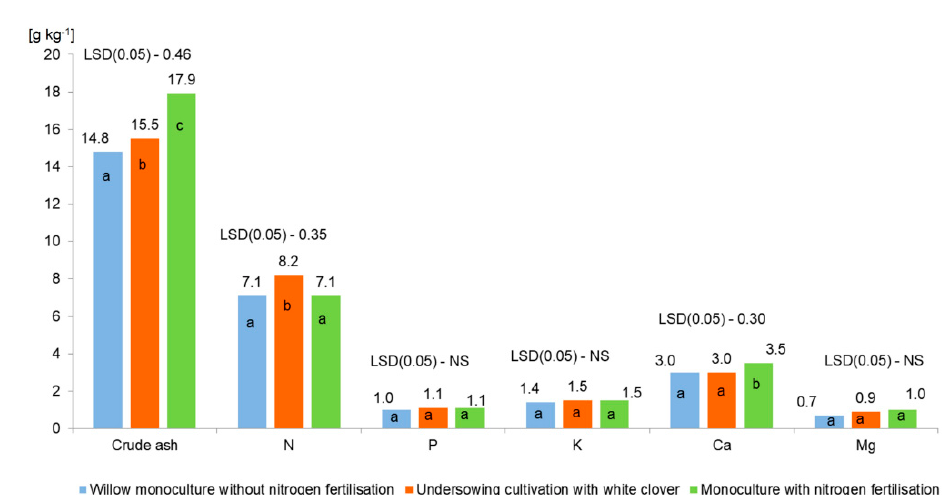
Figure 2. Nutrient content in whole willow plants with two fertilizing treatments and undersow- ing system (average for 2016–2017). LSD—the least significant difference. NS—difference is not significant. Different letters indicate significant differences between treatments (Tukey’s multiple range test).